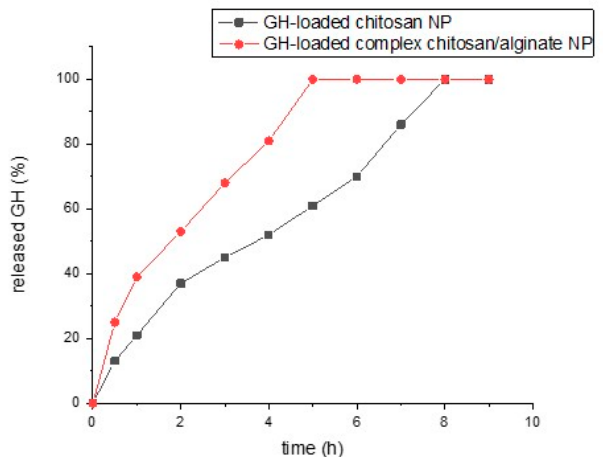
Figure 5. GH release from chitosan NPs and complex chitosan/alginate NPs in PBS (pH 7.2) at 37